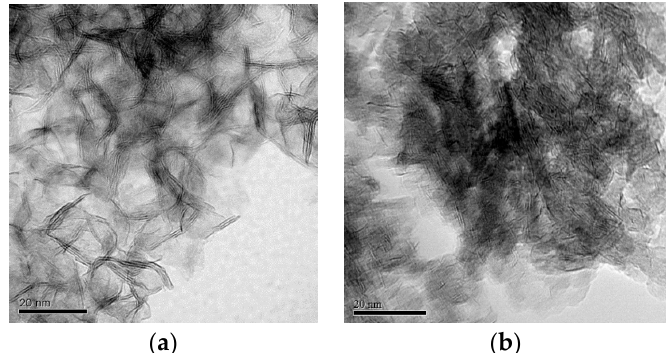
Figure 1. TEM images of unsupported and supported CoMoS catalysts. ( a ) Unsupported catalyst and ( b ) supported catalyst. Table 1. Basic properties of unsupported and supported CoMoS catalysts.